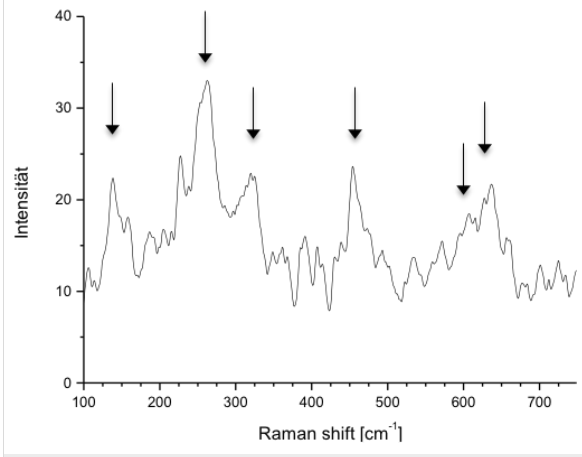
Figure 5: Raman spectrum of oxidic microtubes of composition Ce 0.13 Zr 0.87 O 2 @SiO 2 displaying resonance signals at 146, 263, 313, (Ce, Zr, and O) shows that oxygen is evenly distributed throughout the whole sample as would be expected from an all oxidic material. The majority of the cerium and zirconium are found on the surface of the spherical Stoeber particles, which indicates that, primarily, the intersticial volume between the silica particles is filled (see Figure 3 TEM and Figure